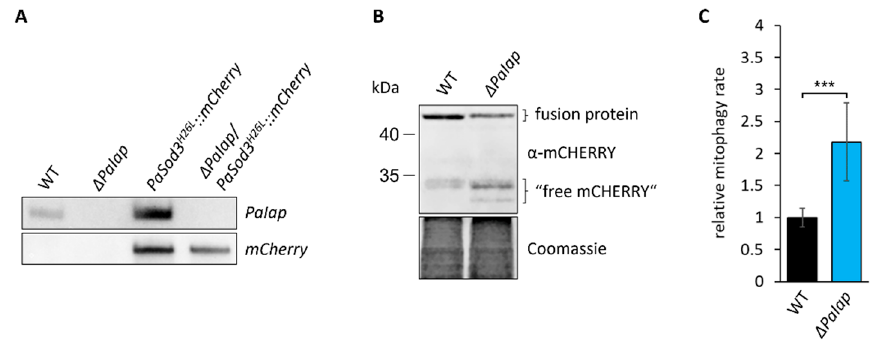
Figure 8. Loss of PaIAP enhances mitochondrial turnover. ( A ): Southern blot analysis of HindIII- digested DNA of the generated mitophagy reporter strain Δ PaIap/PaSod3 H26L ::mCherry . ( B) : Western blot analysis of isolated protein extracts of 6-day-old PaSod3 H26L ::mCherry (here WT) and Δ PaIap/PaSod3 H26L ::mCherry (here Δ PaIap ) grown in liquid CM medium. Coomassie staining was used as loading control. ( C ) : Quantification of mitophagy rate in ( B ). Mitophagy rate was deter- mined by ratio of “free mCHERRY” to total “free mCHERRY” + PaSOD3 H26L ::mCHERRY (fusion protein). Data represent mean ± SD ( PaSod3 H26L ::mCherry n = 9; Δ PaIap/PaSod3 H26L ::mCherry n = 10). *** p < 0.001.